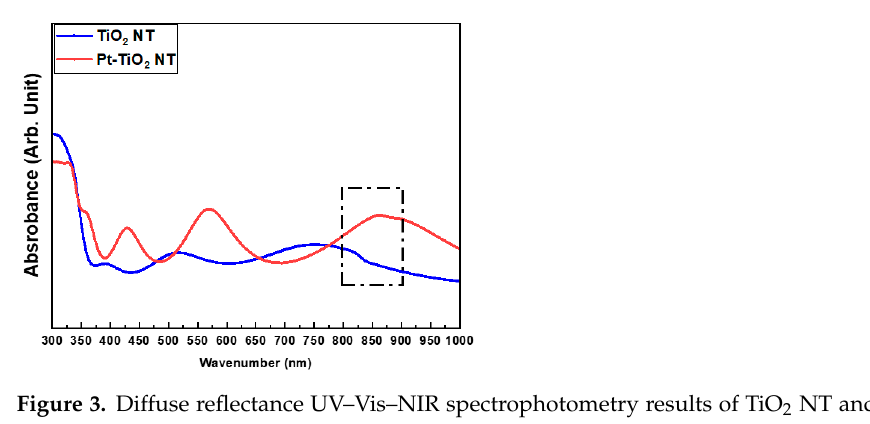
Figure 3. Diffuse reflectance UV–Vis–NIR spectrophotometry results of (a) TiO 2 NT and (b) Pt-TiO 2 NT (sputtering time: 60 s).